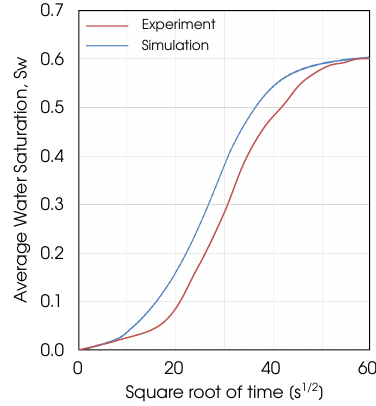
Figure 14. Model CUBE: comparison of FMT between physical experiment and